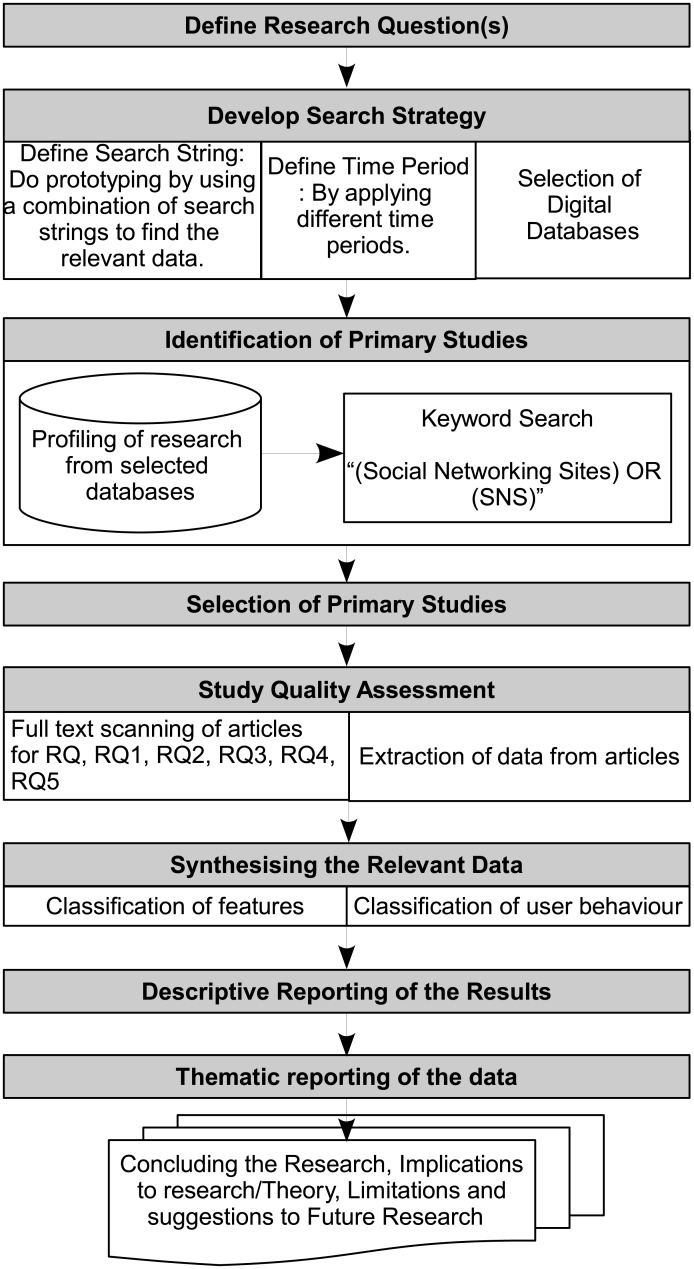
Research process.